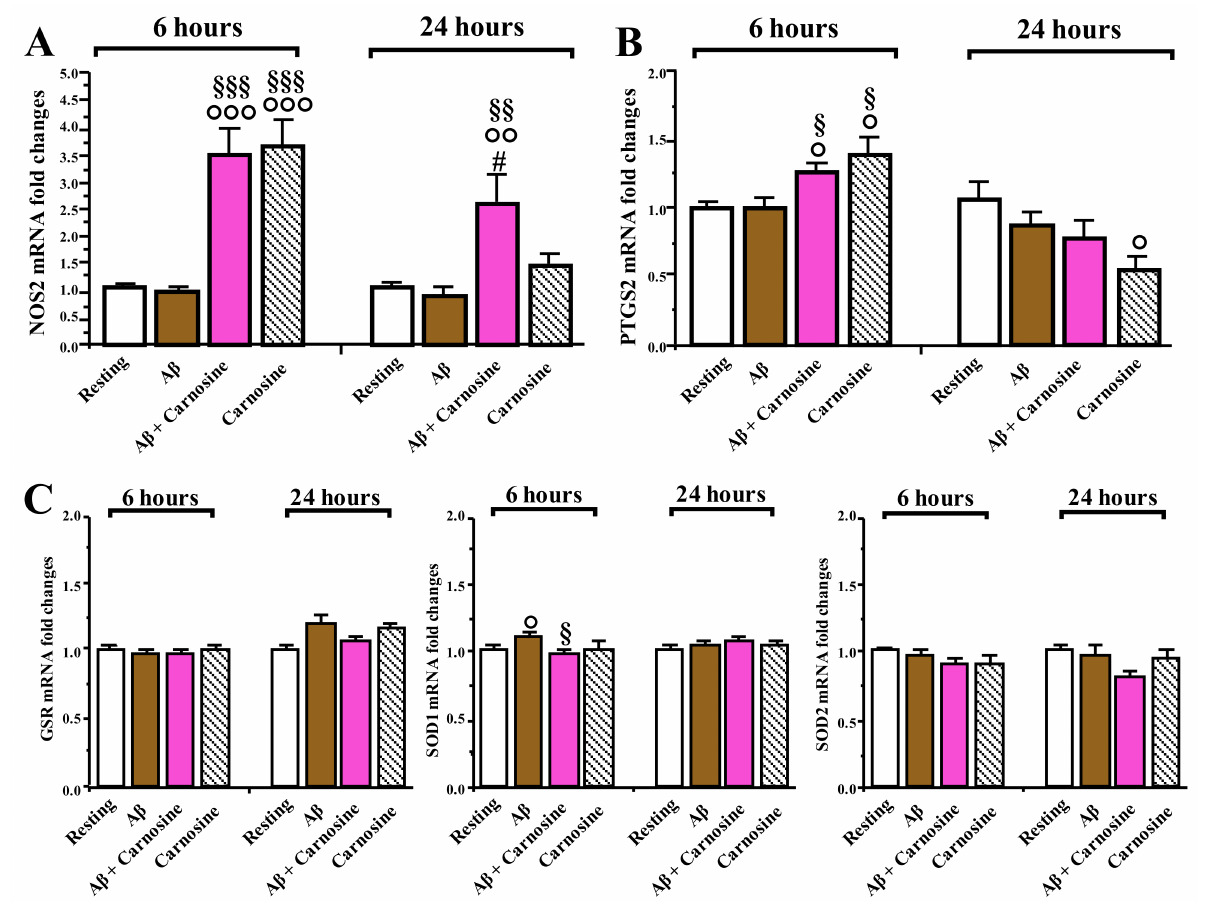
Figure 7. Effects of exposure of RAW 264.7 cells to A β 1-42 oligomers (2 µ M) for 6 and 24 h in the absence or presence of carnosine (20 mM; 1 h pre-treatment) on expression levels of enzymes related to inflammation and oxidative stress. mRNA expression of ( A ) inducible nitric oxide synthase (NOS2) , ( B ) prostaglandin-endoperoxide synthase 2 (PTGS2) , ( C ) glutathione reductase (GSR) , and superoxide dismutase (SOD) 1 and 2 , with GAPDH / CypA as endogenous control, was measured by qRT- PCR. Data are represented as means ( n = 8–12) ± S.E.M. ◦ significantly different from resting cells, p < 0.05; ◦◦ significantly different from resting cells, p < 0.01; ◦◦◦ significantly different from resting cells, p < 0.001; § significantly different from A β 1-42 oligomer-treated cells, p < 0.05; §§ significantly different from A β 1-42 oligomer-treated cells, p < 0.01; §§§ significantly different from A β 1-42 oligomer-treated cells, p < 0.001; # significantly different from carnosine alone, p <